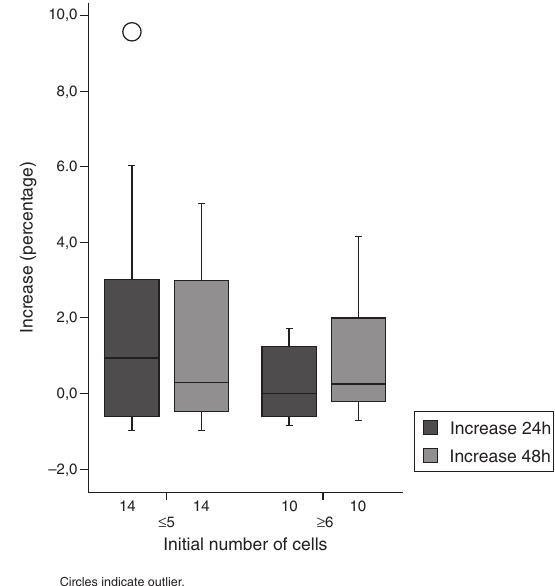
Figure 2 Percentage of cells in both groups (1 and 2) related to time: 0 h, 24 h and 48